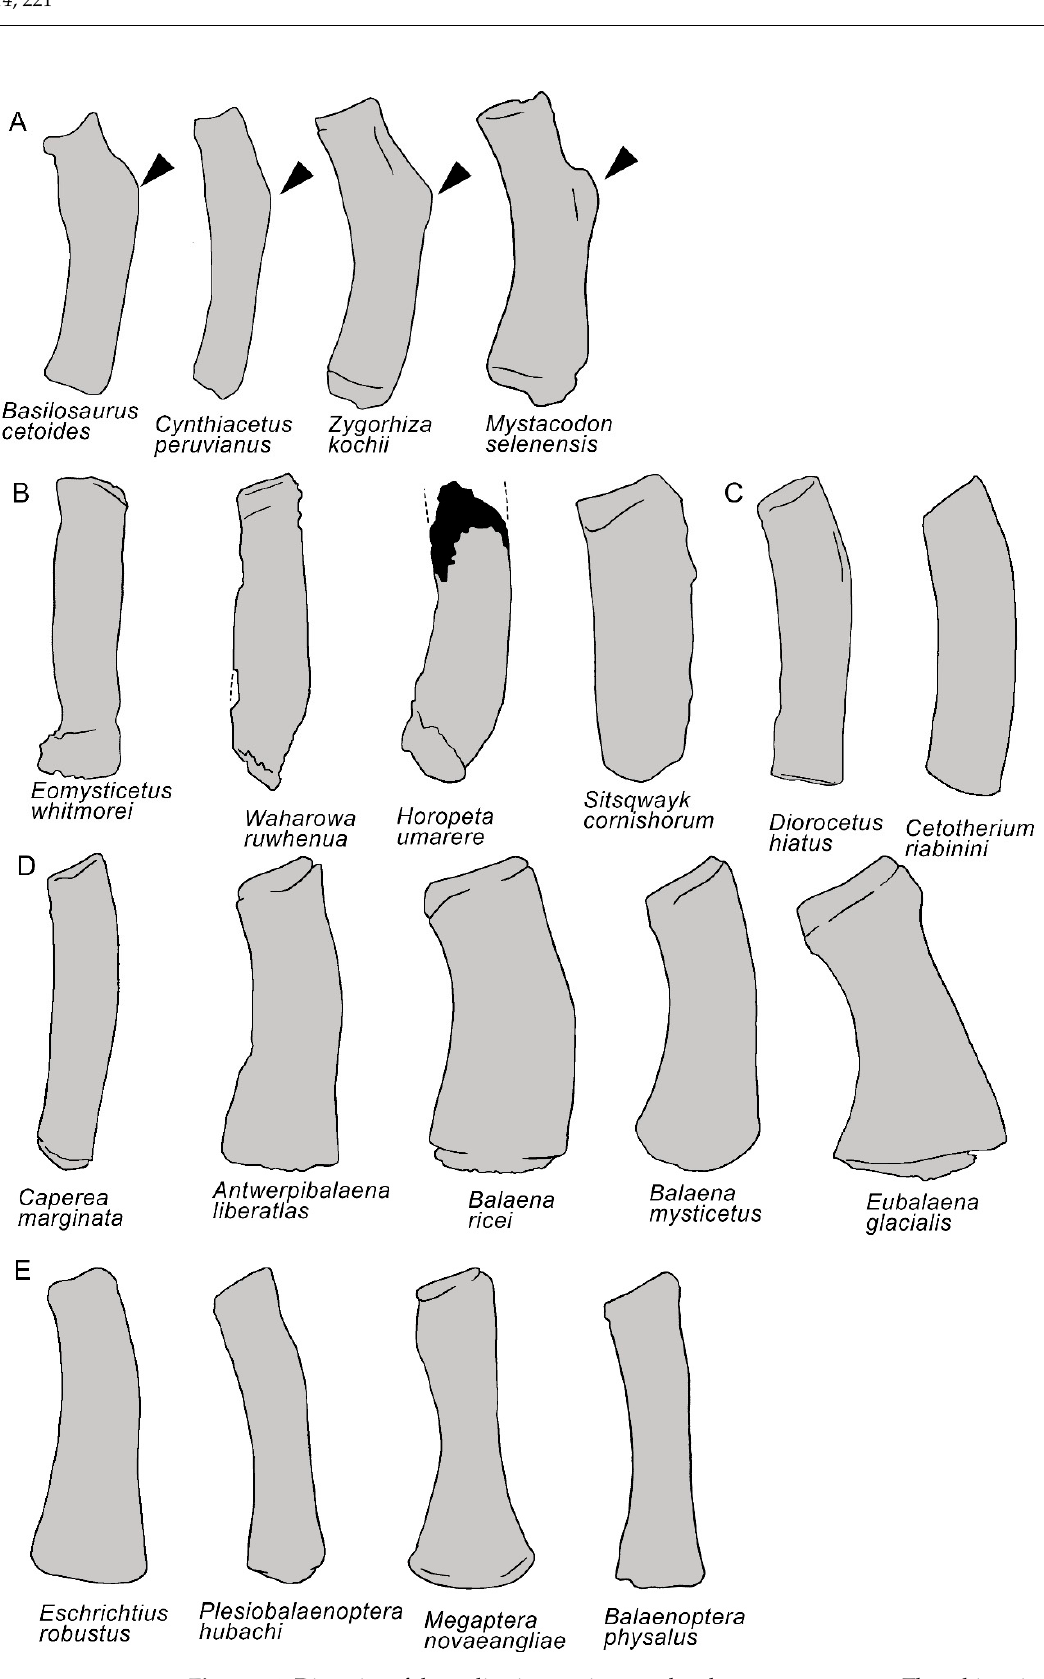
Figure 24. Diversity of the radius in mysticete and archaeocete cetaceans. The white triangle indicates the radial crest. ( A ) Archaeocetes. ( B ) Eomysticetidae and stem-balaenomorph taxa. ( C ) A basal thalassotherian taxon and a Cetotheriidae. ( D ) Balaenoidea. ( E ) Balaenopteroidea. Not to scale. The scapulae are represented as if they shared the same anteroposterior length.